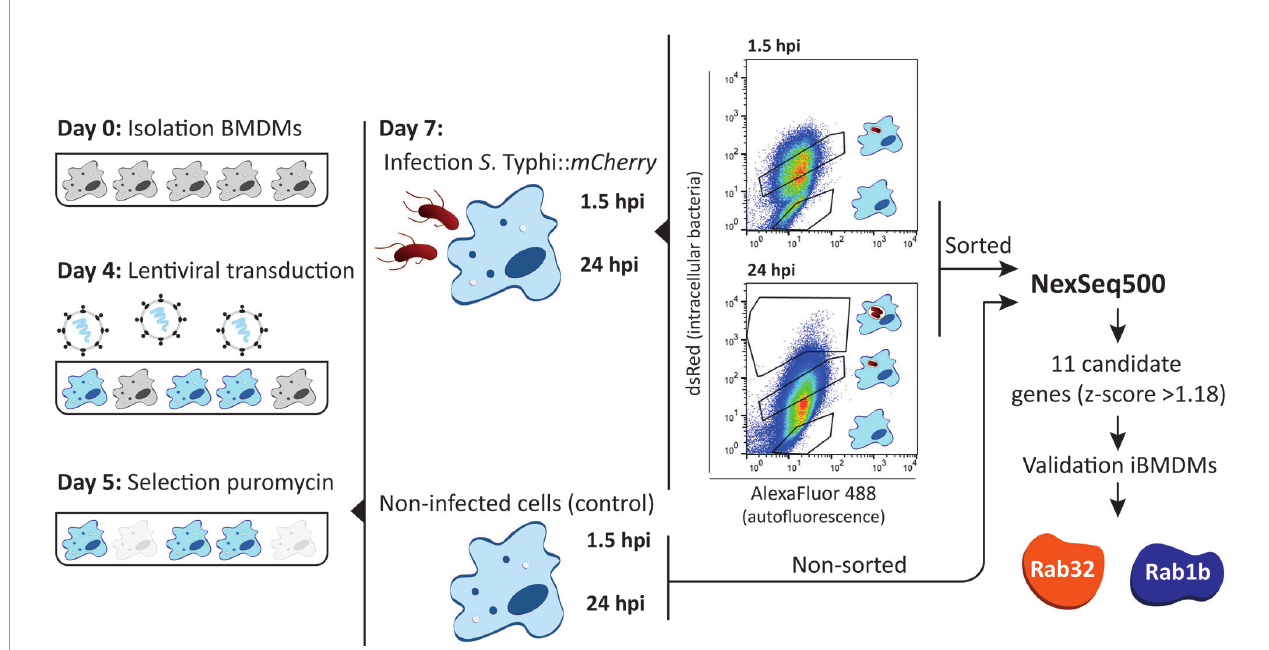
FIGURE 1 | shRNA screening in BMDMs. Schematic representation of the experimental approach of the shRNA screening in BMDMs. BMDMs were isolated from casp1-/- mice and transduced at day 4 after isolation. After selection with puromycin for 48 hours, cells were infected with S . Typhi:: mCherry . At 1.5 and 24 hours post-infection cells were fi xed with 4% PFA and the different sub-populations sorted based on dsRed fl uorescence (gates for the different sub-populations indicated). Genomic DNA from sorted and non-sorted cells (control) was isolated, the region encoding the shRNA ampli fi ed by PCR and the amplicons sequenced by next- generation sequencing (NextSeq500). As a result of the screen, 11 candidate genes were identi fi ed based on a z-score >1.18 and hits validated using shRNAs to knockdown the individual